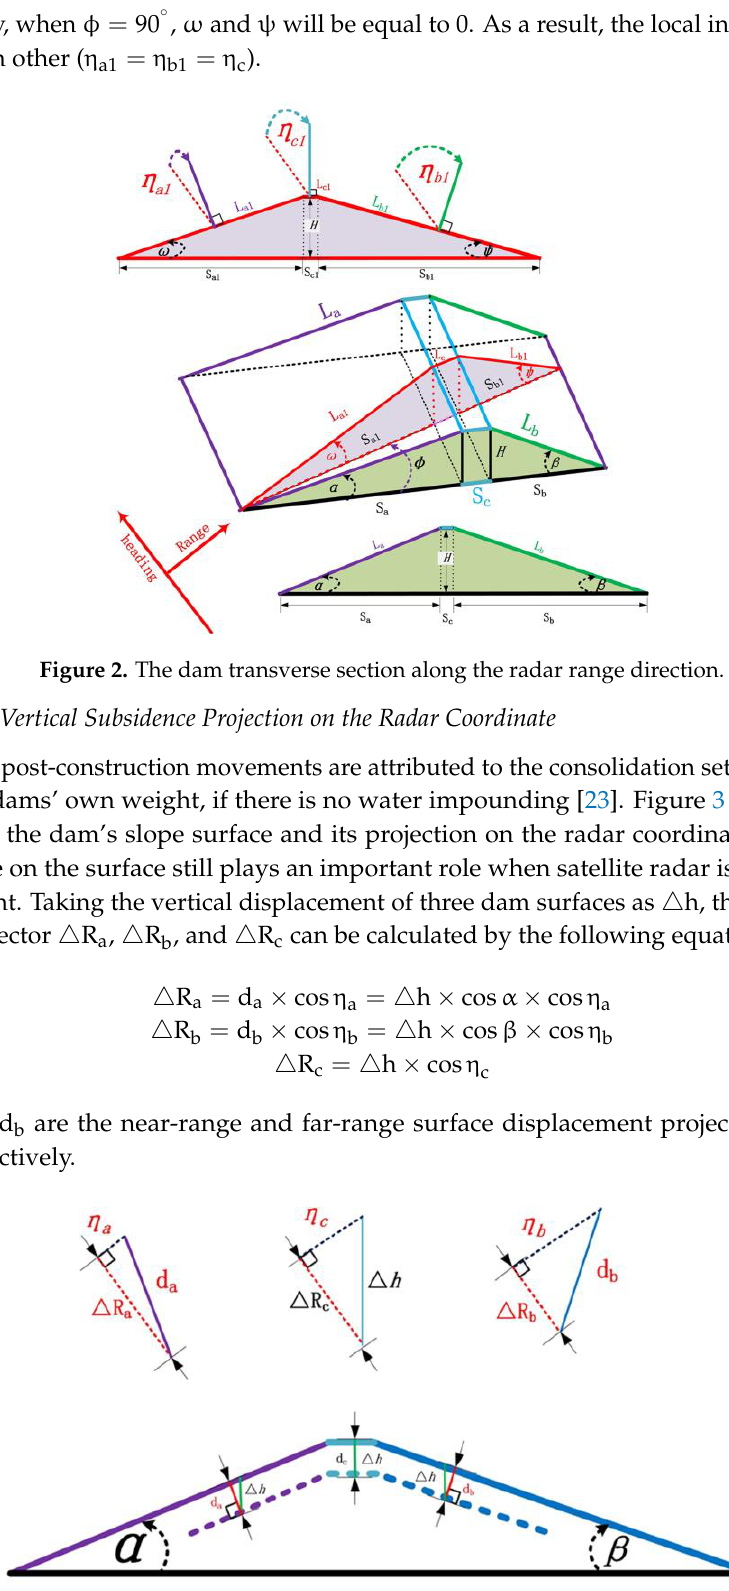
Figure 2. T he dam transverse section along the radar range direction.